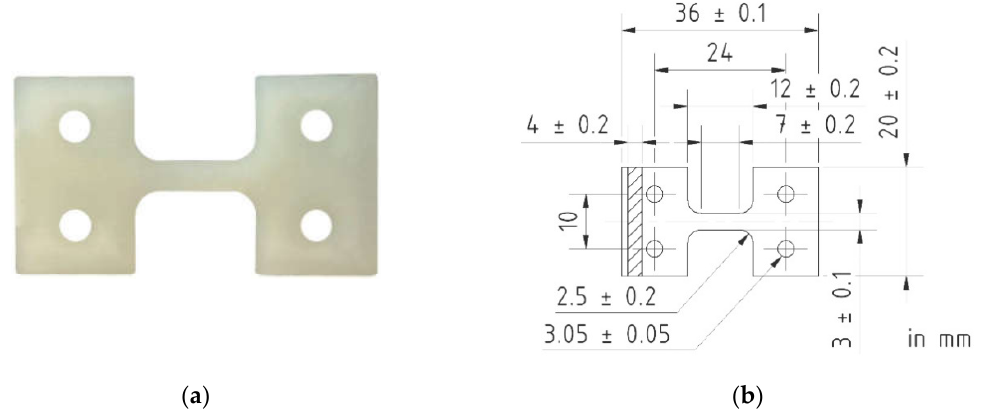
Figure 1. ( a ) Image of a tensile test specimen from Ultramid B3EG6 and ( b ) technical drawing with dimensioning.